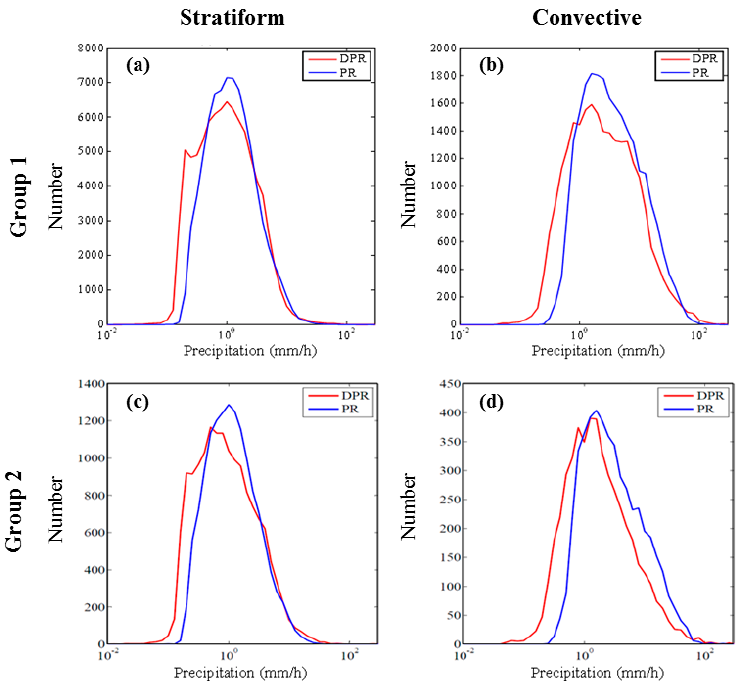
Figure 9. Frequency distributions for: ( a , c ) stratiform; and ( b , d ) convective precipitation estimates based on the coincident events in Group 1 and 2. The coordinates in x -axis is exponential, ranging from 0.01 to 300 mm/h and divided into 50 bins.